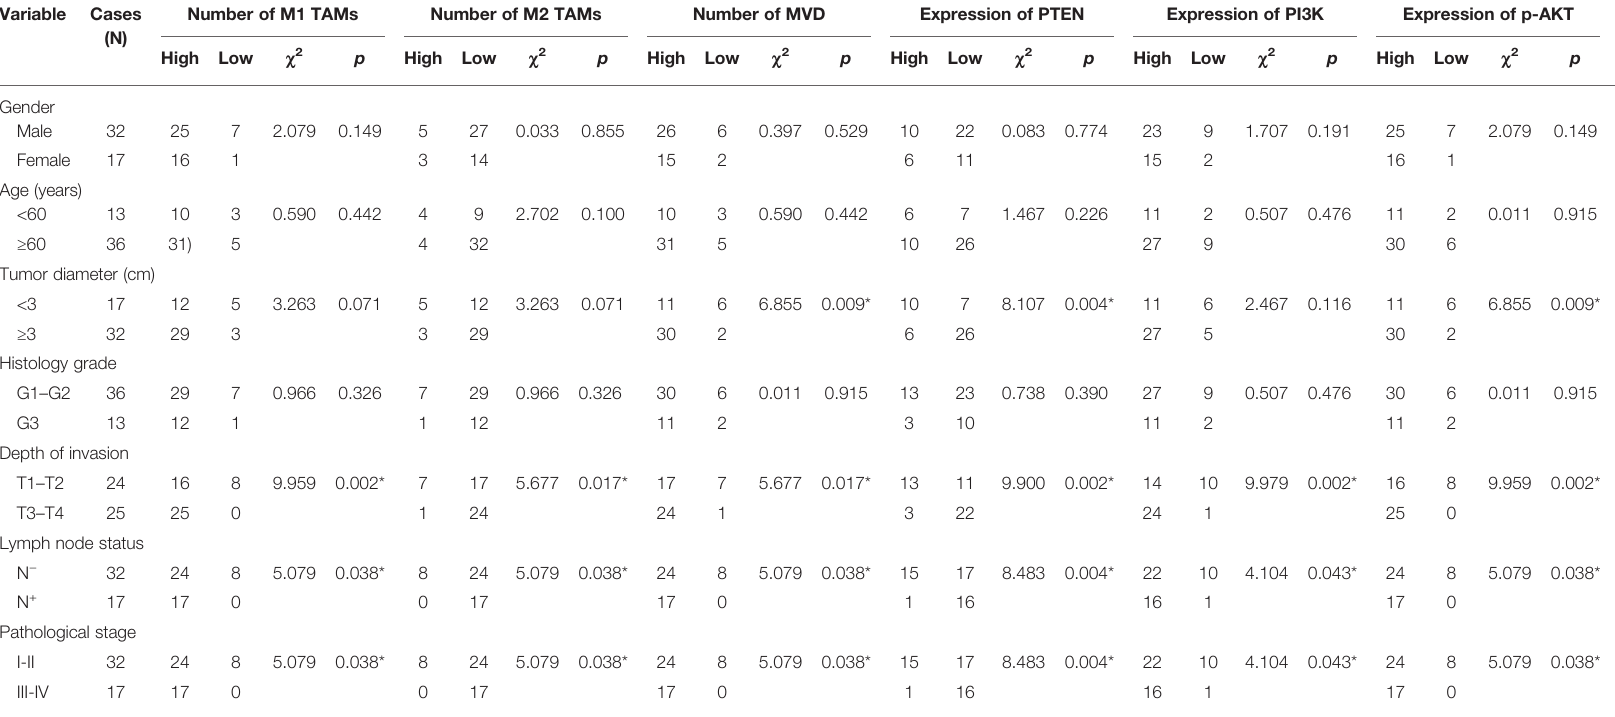
TABLE 3 | Correlation between the extent of TAM in fi ltration, MVD value, PTEN/PI3K/p-AKT expression, and clinicopathological parameters. Variable Cases